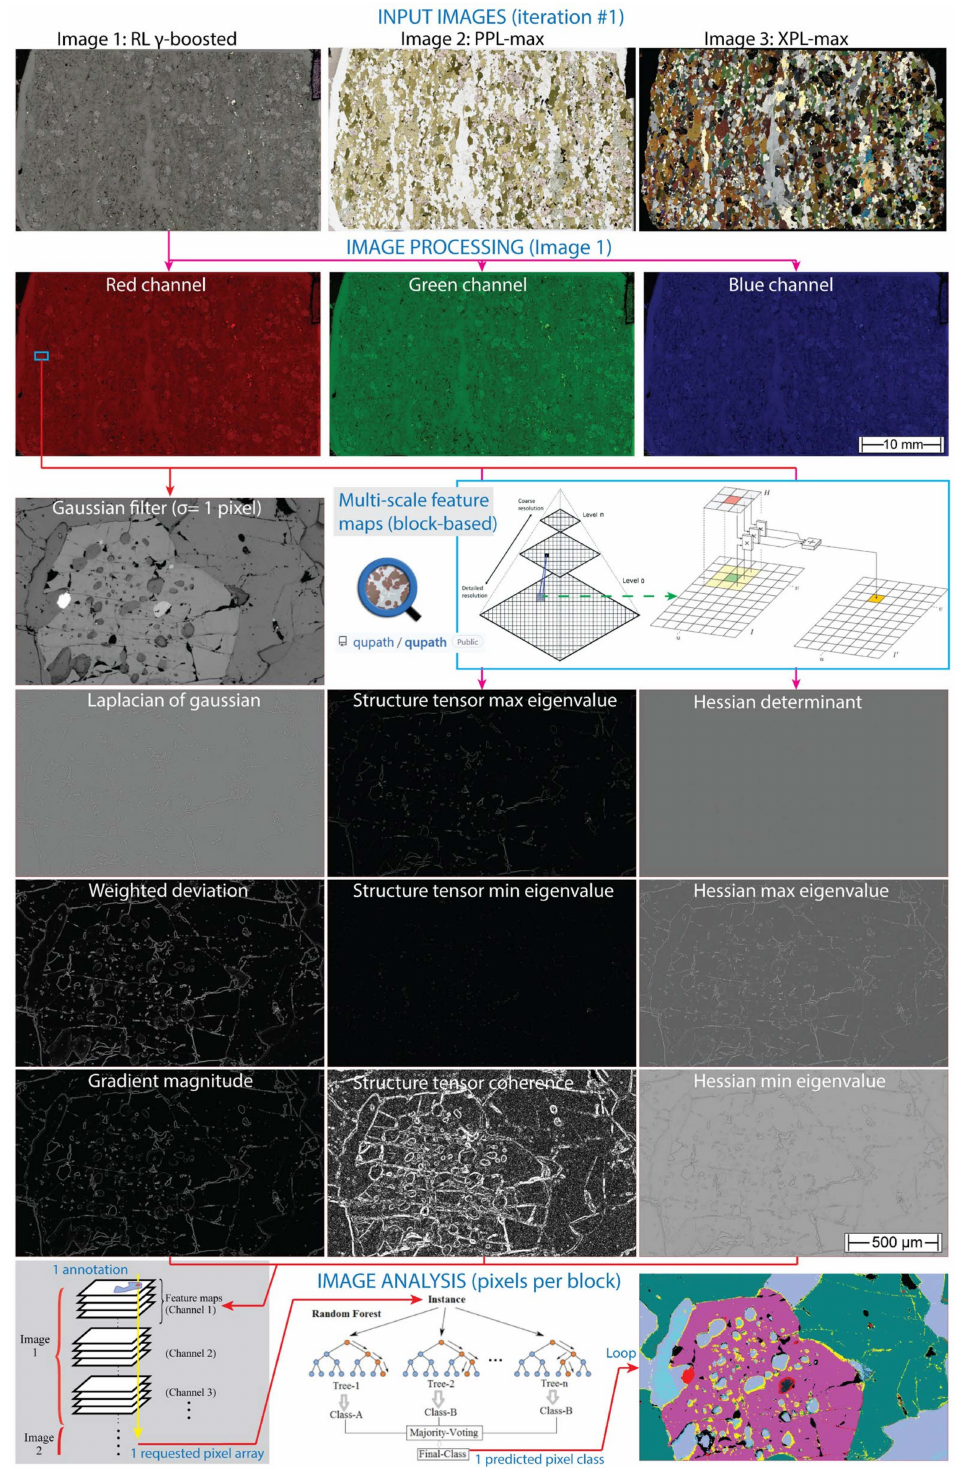
Figure 8. QuPath ‘Pixel classifier’ workflow on the registered image stack ( top ) that is split into red-green-blue image layers (RGB) and then processed block-wise. The multi-scale feature map calculation (blue box inset) uses filtering for all selected channels. This helps find characteristic features with a random trees model during prediction. A loop reconstructs the phase map for each pixel and block (bottom-right). Sample ID: granulite-facies metabasite